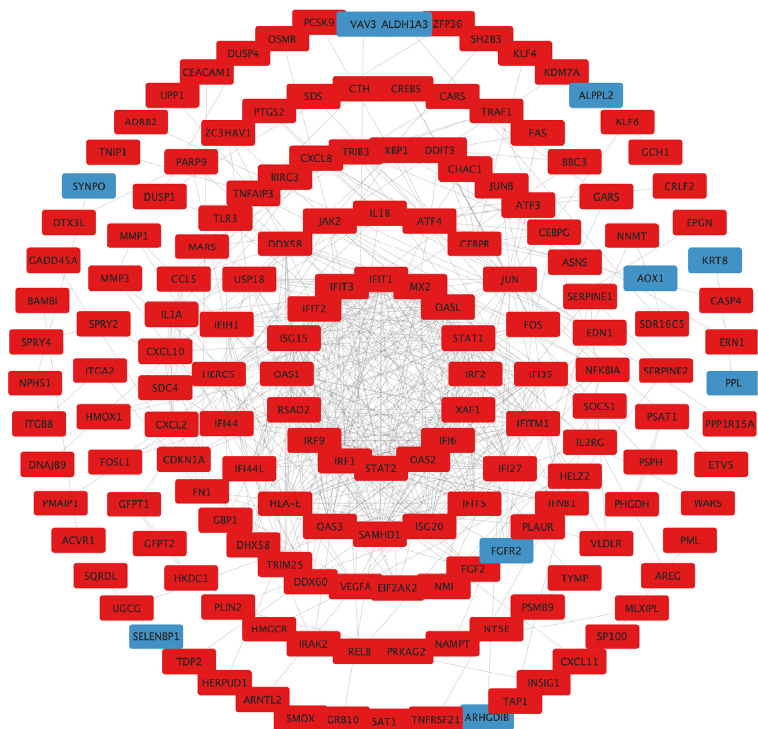
Figure 6. PPI network construction. Circle size reflects importance in the network (a smaller circle indicates more importance in the network). Red mark, upregulated DEGs; blue mark, downregulated DEGs; PPI, protein–protein interaction; DEGs, differentially expressed genes.